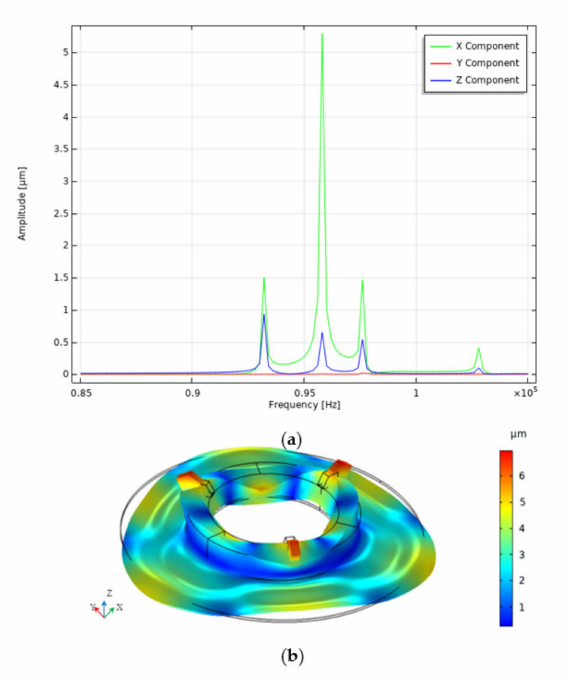
Figure 7. Results of numerical analysis of harmonic response with the disc-shaped flange: ( a ) amplitude vs. frequency characteristic; ( b ) At resonance mode, 95.8 kHz